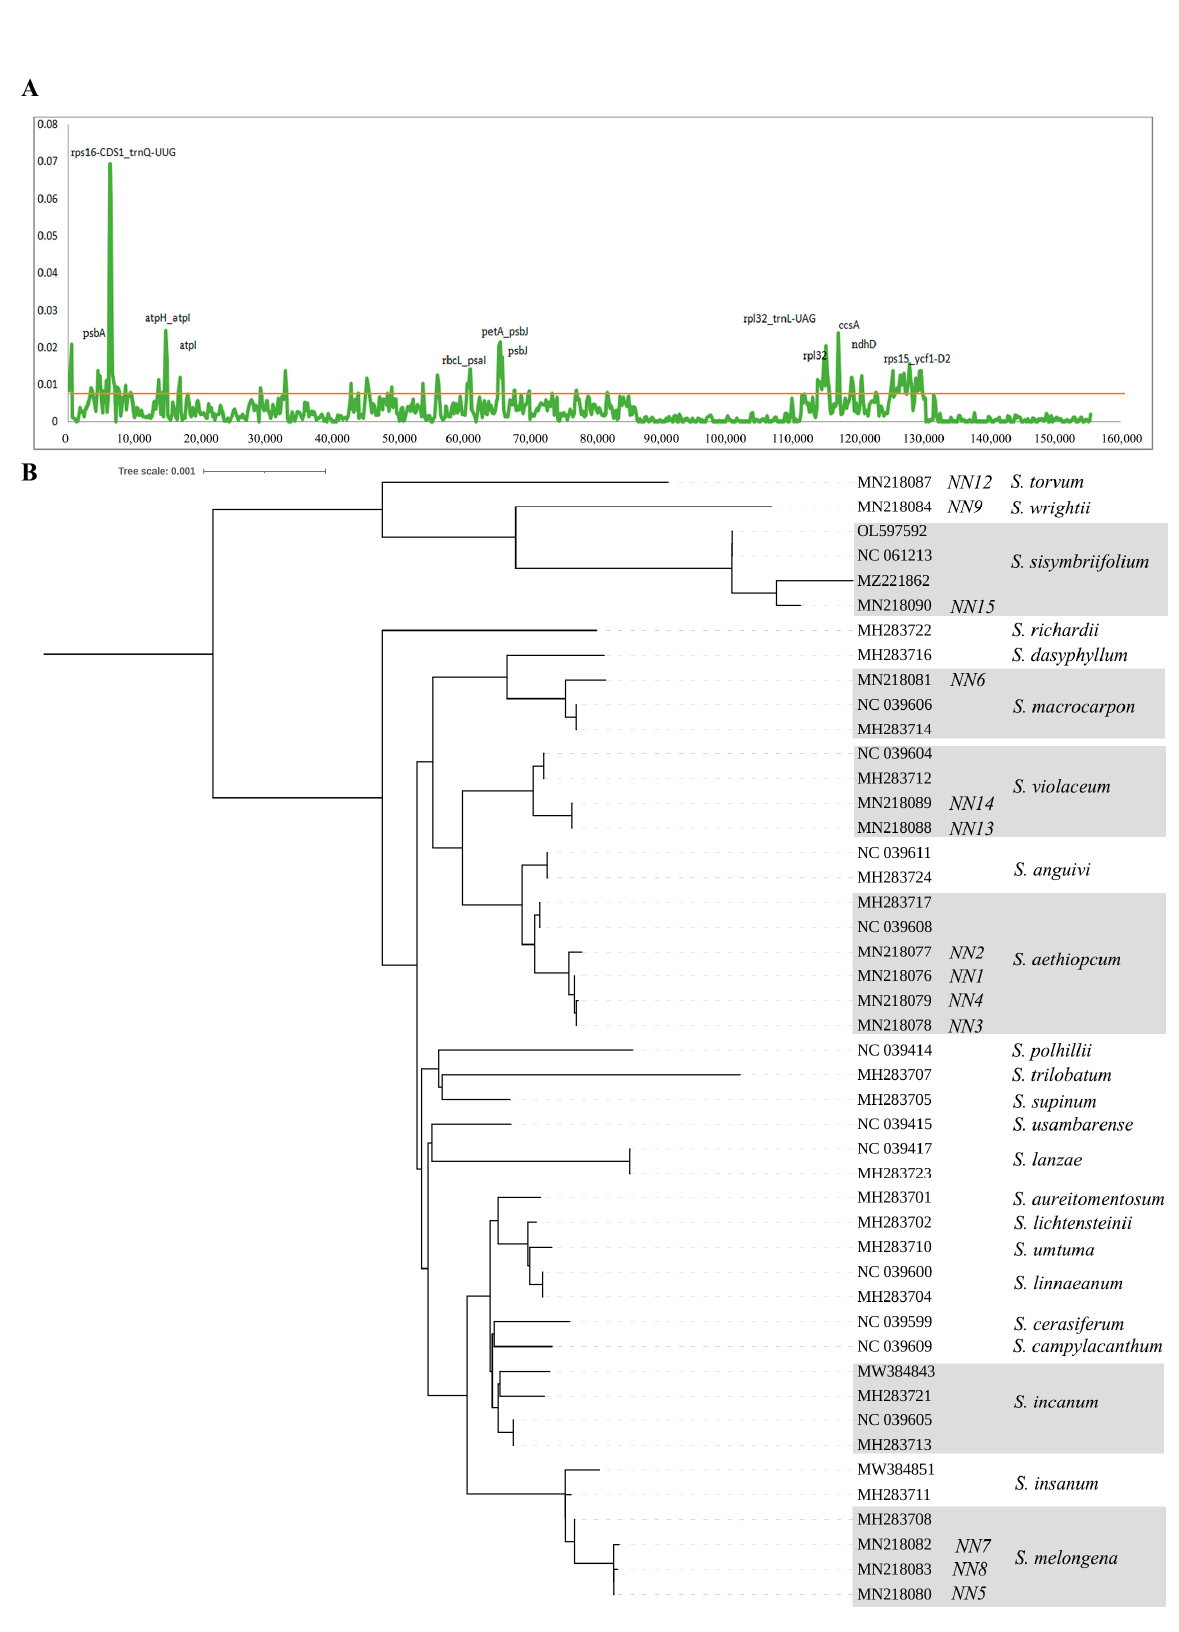
Figure 4. Variable regions and phylogenetic tree of the Solanum species. ( A ) Comparison of variable regions among 46 Solanum cp genomes. ( B ) Phylogenetic analysis of 46 Solanum cp genomes.